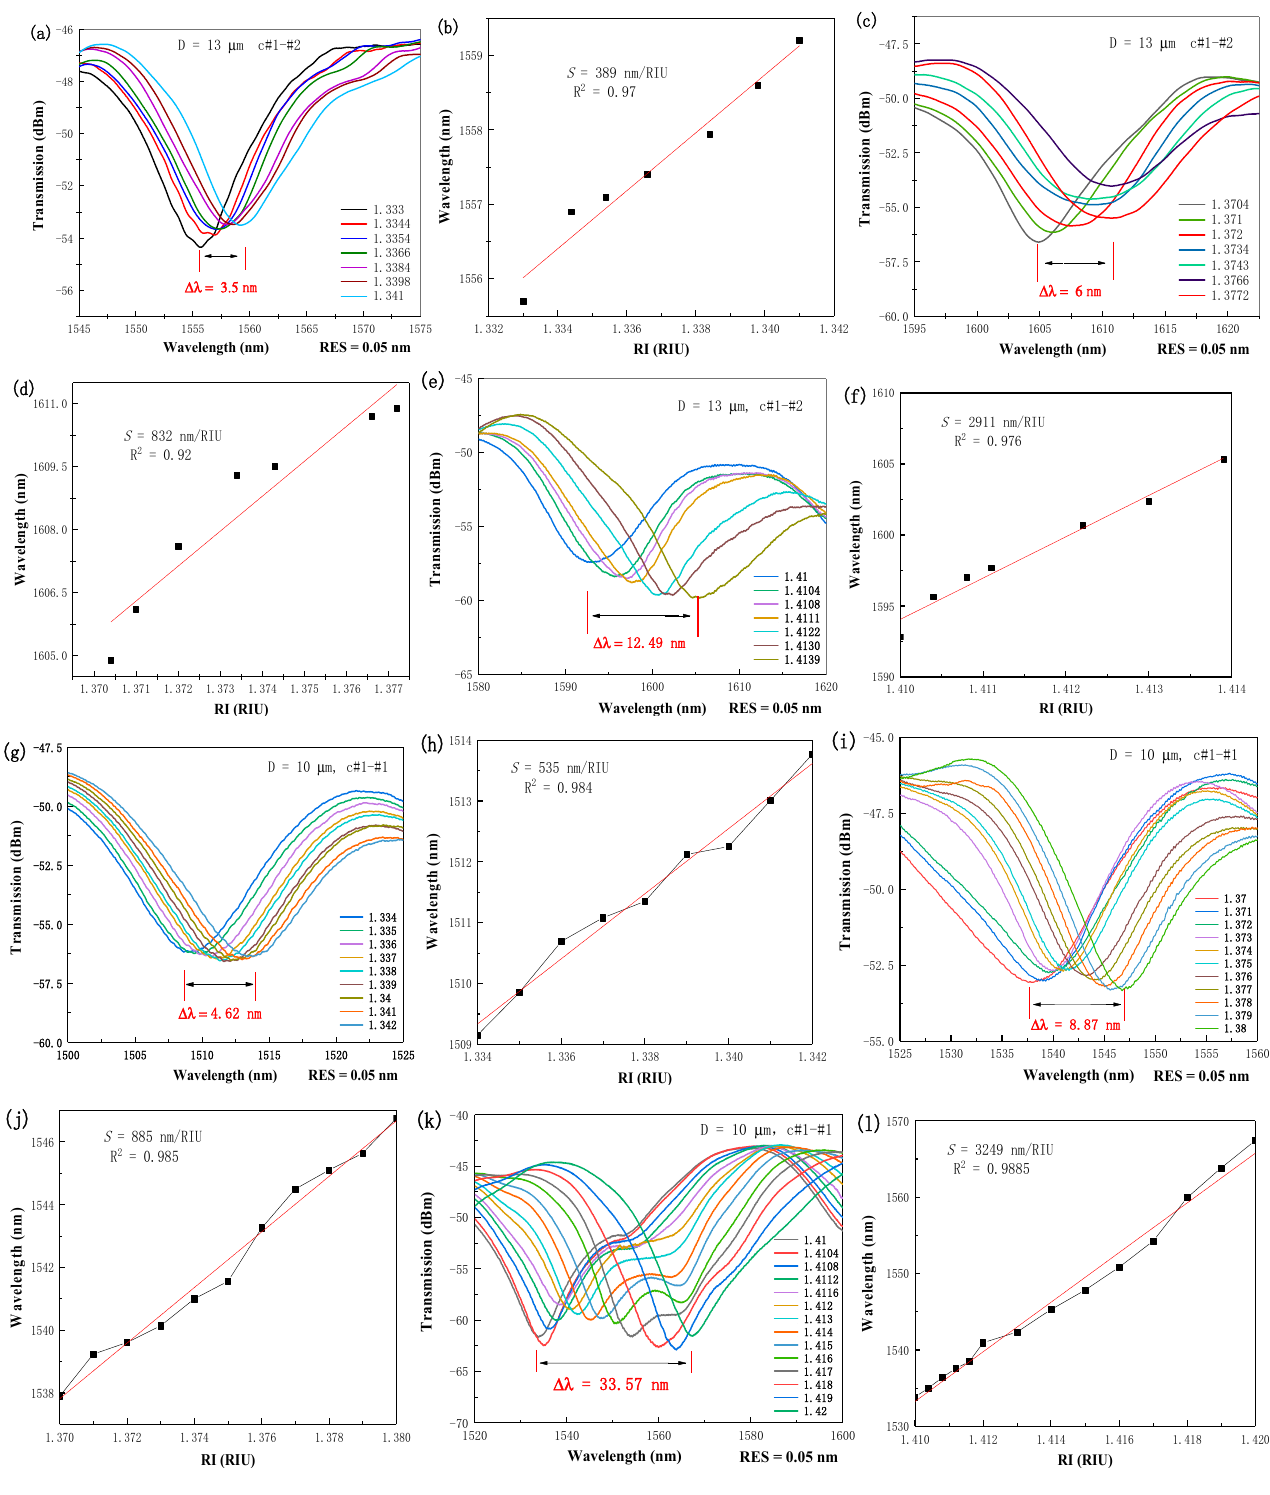
Figure 4. Spectral responses of the wavelength shift versus index variations for ( a ) sample A 3 over the index range 1.333–1.341, ( c ) 1.3704–1.3772, ( e ) 1.41–1.4139 and for sample A 4 over